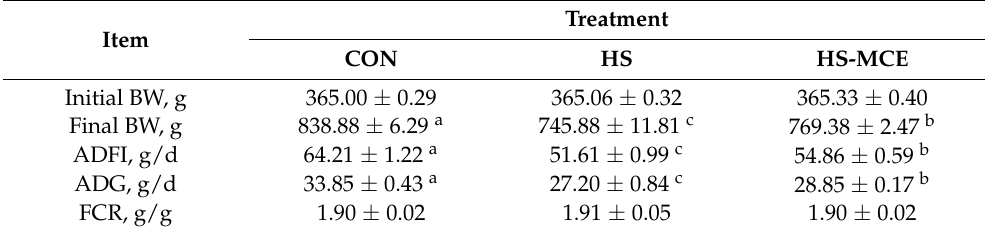
Table 2. Effects of HS and MCE on growth performance of yellow-feathered broilers.